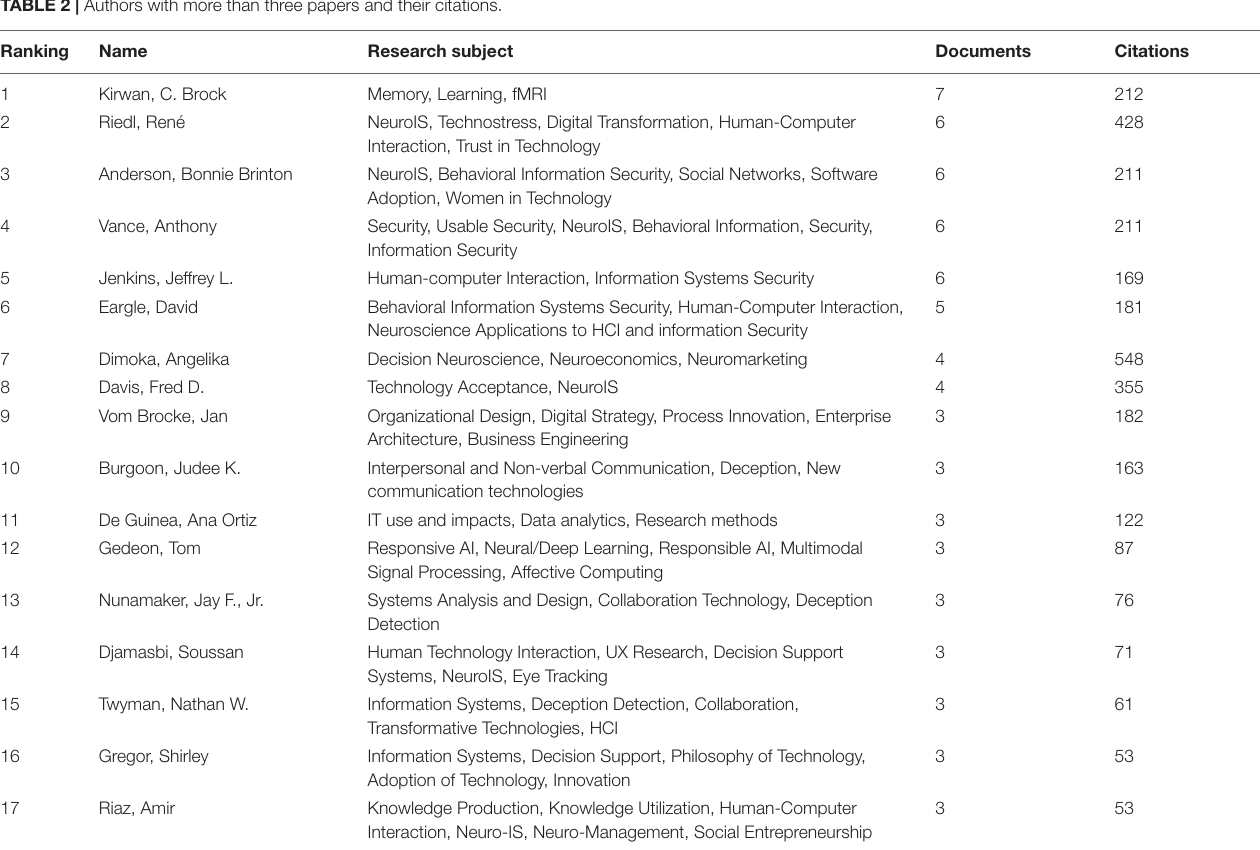
TABLE 2 | Authors with more than three papers and their